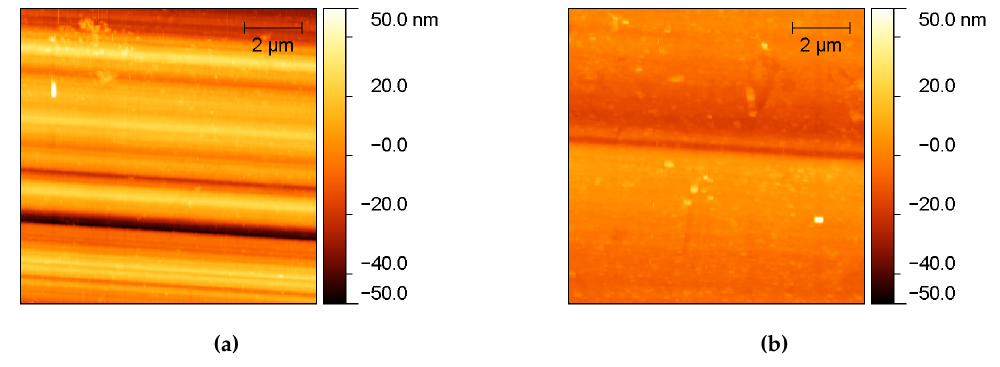
Figure 9. 10 × 10 µ m 2 AFM images of the bottom surface ( a ) and the lateral surface ( b ) of the test channels realised by mechanical micromachining with the dicing saw. The colour scale is the same for both of the images to allow for a better